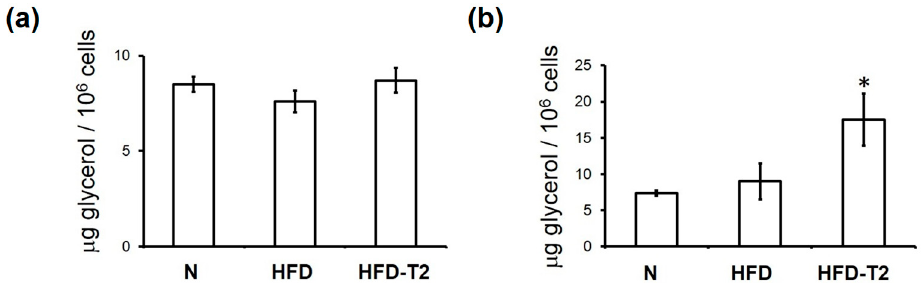
Figure 2. Effect of 3,5-T2 administration to rats fed a high-fat diet on the onset of lipolysis in VAT. Glycerol release from adipocytes isolated from VAT after administration of 3,5-T2 to rats simultaneously fed a high-fat diet (HFD-T2) for 1-day ( a ), and 1-week ( b ), when compared to the HFD-fed (HFD) rats and chow-fed (N) controls. The mean values shown are ± SEM ( n = 4). * p < 0.05 vs. N and HFD.